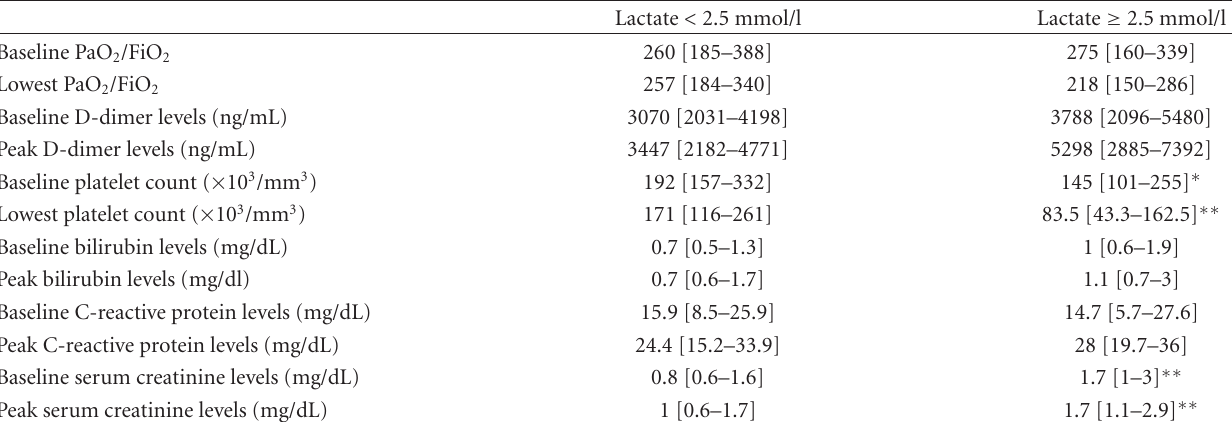
Table 2: Baseline and peak laboratory parameters of organ